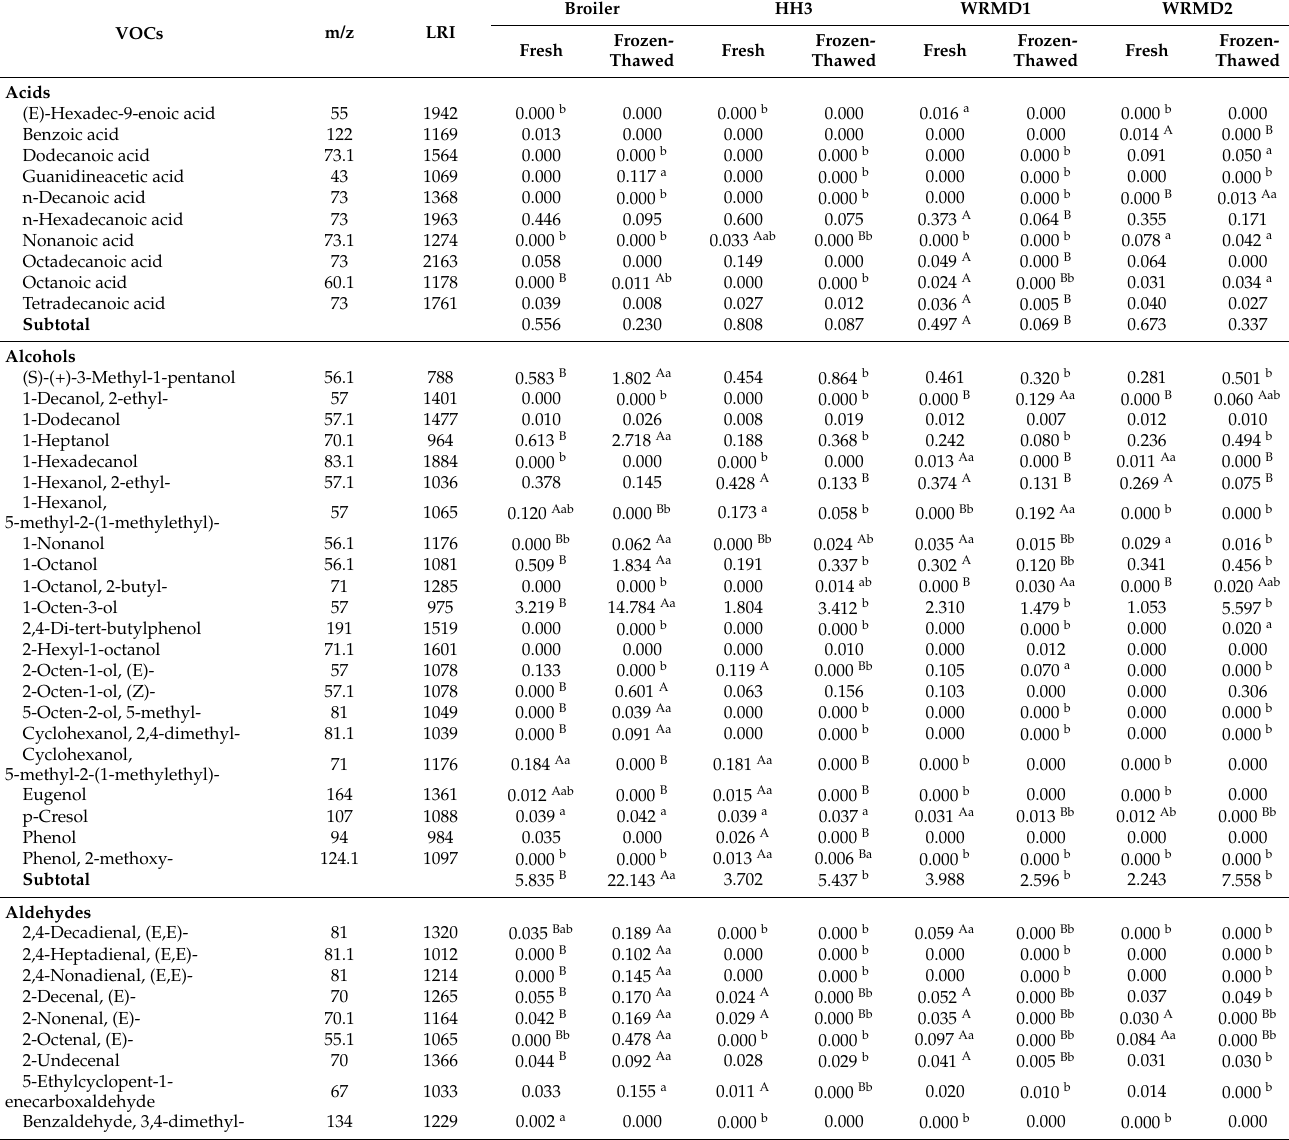
Table 6. Comparison of volatile organic compounds of fresh and Frozen-Thawed chicken meats from Korean native chickens and broilers (A.U. × 10 6